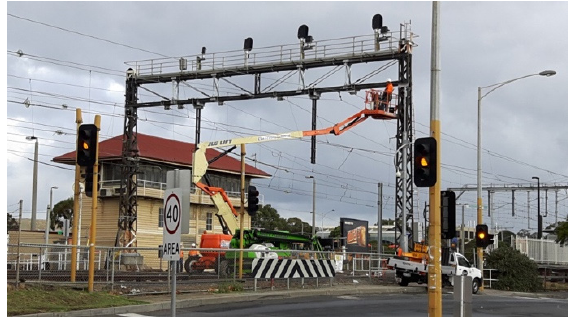
Figure 6. A signal gantry.